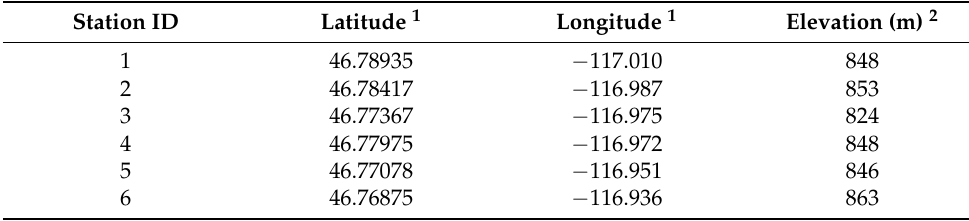
Table 1. Seismic station location description.